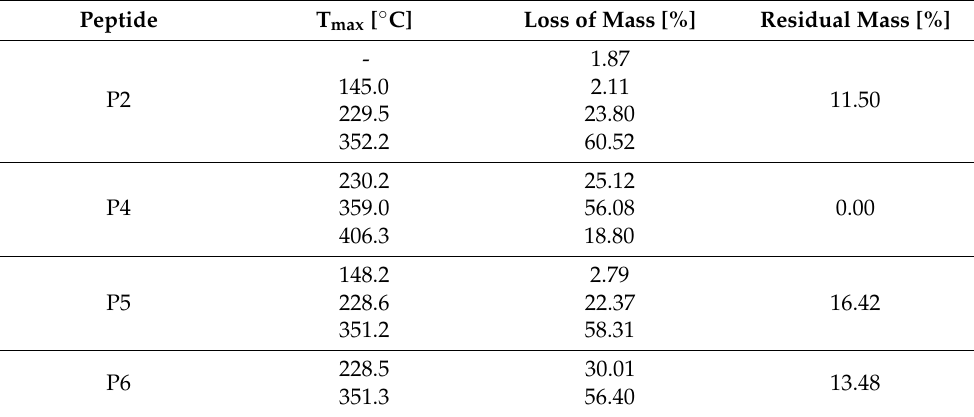
Table 1. Tmax, weight loss, and residual weight of assessed peptides P2, P4–P6 according to performed TD and DTG plots.